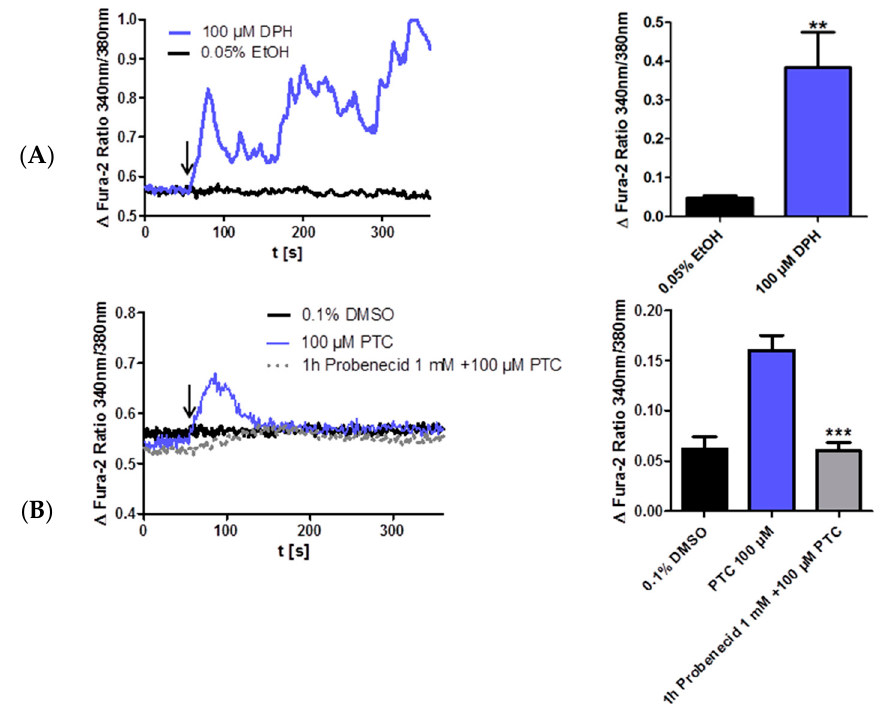
Figure 3. DPH and PTC induce calcium influx in JEG-3 cells. ( A ) JEG-3 cells are stimulated after 60 s with DPH (100 µM) or DMSO (0.1%) as indicated with the arrow and calcium currents are analyzed by calcium imaging. Calcium influx is expressed as the difference of the fura-2 ratio before and after stimulation; ( B ) JEG-3 cells are stimulated after 60 s with PTC (100 µM) or DMSO (0.1%) as indicated with the arrow. Calcium currents are analyzed by calcium imaging. Calcium influx is expressed as the difference of the fura-2 ratio before and after stimulation. 1 h pre-incubation with probenecid (1 mM) reduces PTC-induced calcium currents to solvent level. Data + SEM. n = 5. t -test, unpaired, two-tailed. ** p < 0.01, *** p < 0.001.